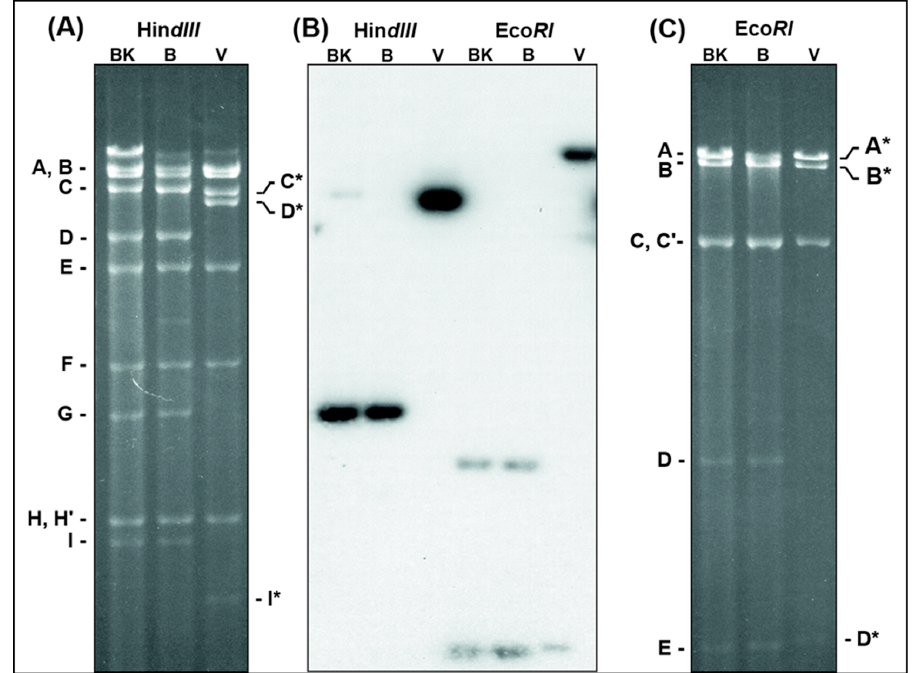
Figure 1. Changes of D1701-V DNA restriction fragment patterns. DNA of D1701-50BK (lanes BK), D1701-B (lanes B) and D1701-V (lanes V) was digested with Hin dIII or Eco RI and separated in a horizontal 0.8% agarose gel for 36 h. The digested DNAs were run in one identical gel, however, for